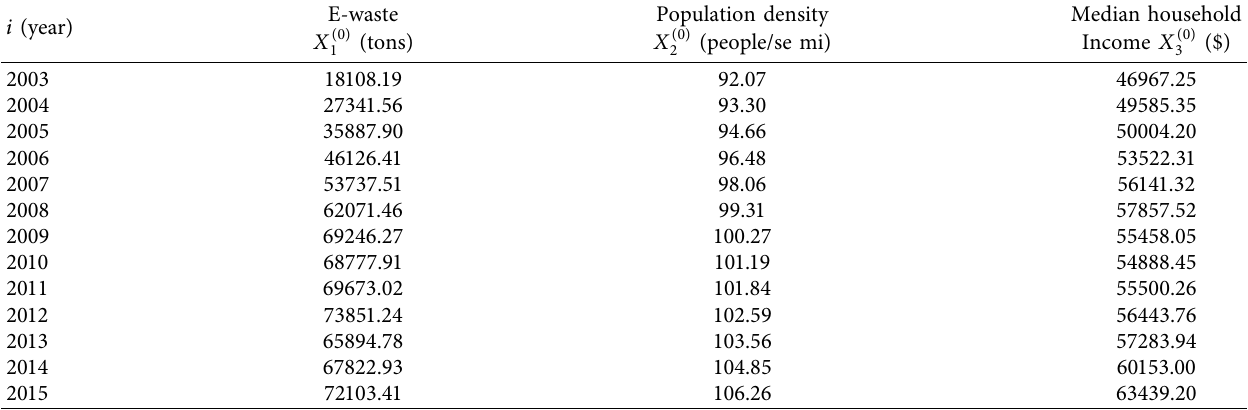
Table 7: E-waste, population density, and median household income in case three.